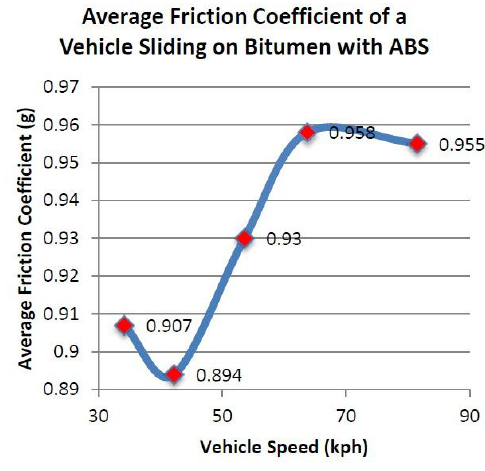
Fig. 5. Average friction coefficient of a skidding vehicle with antilock braking system